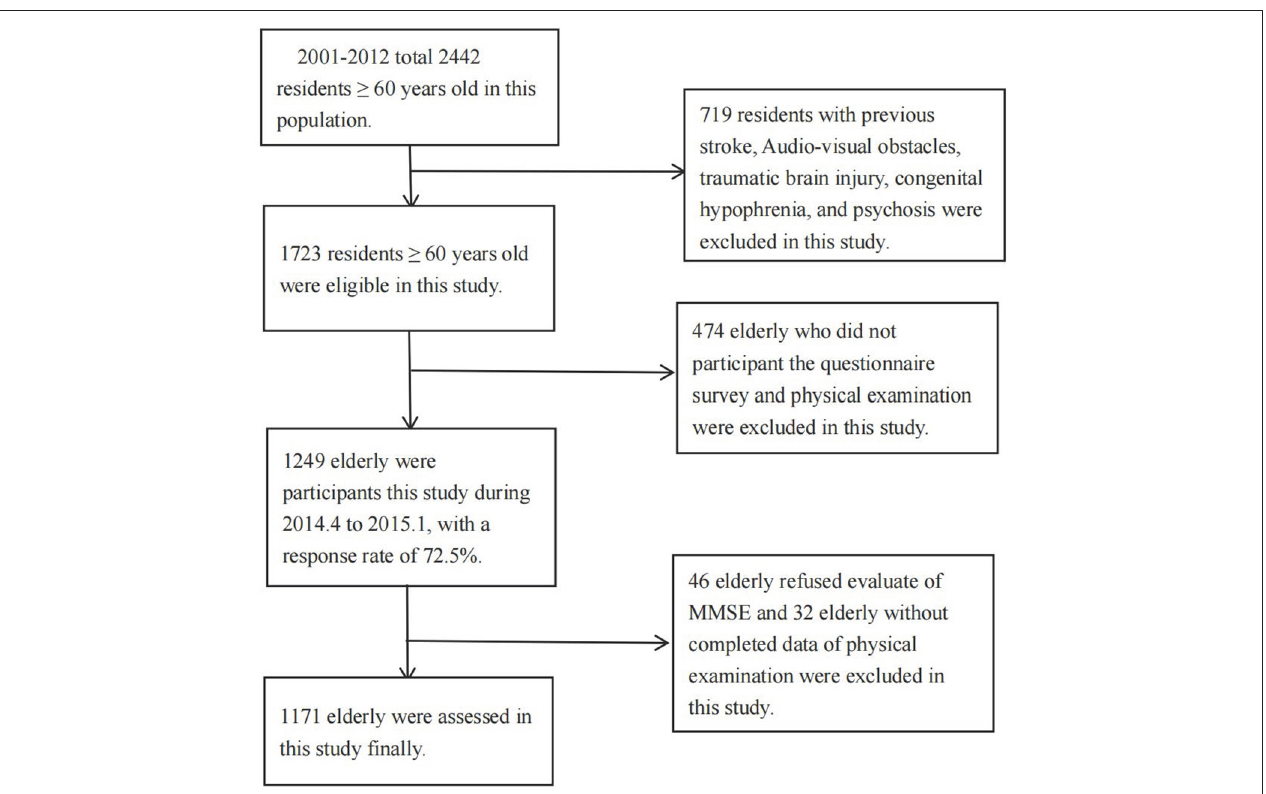
FIGURE 1 | Flow chart of participants. 2001-2012 total 2,442 residents ≥ 60 years old in this population. Eight hundred and thirty nine residents with previous stroke, Audio-visual obstacles, traumatic brain injury, congenital hypophrenia, and psychosis were excluded in this study; 474 elderly who did not participant the questionnaire survey and physical examination were excluded in this study; 46 elderly refused evaluate of MMSE and 32 elderly without completed data of physical examination. Finally, 1,171 elderly were assessed in this